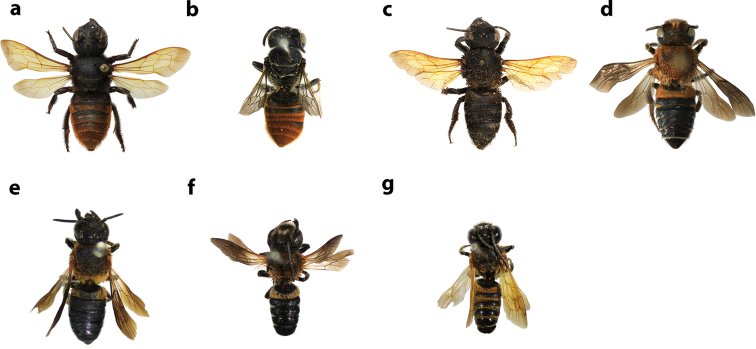
Dorsal view of some Thai Callomegachile (a–e females, f, g male) aM. (Callomegachile) parornatabM. (Carinula) stultacM. (Callomegachile) tuberculatad, fM. (Callomegachile) umbripenniseM. (Callomegachile) umbripennis (BSRU AA-4620) gM. (Callomegachile) umbripennis (BSRU AA-3654, BSRU AA-3662 and KKIC-02).